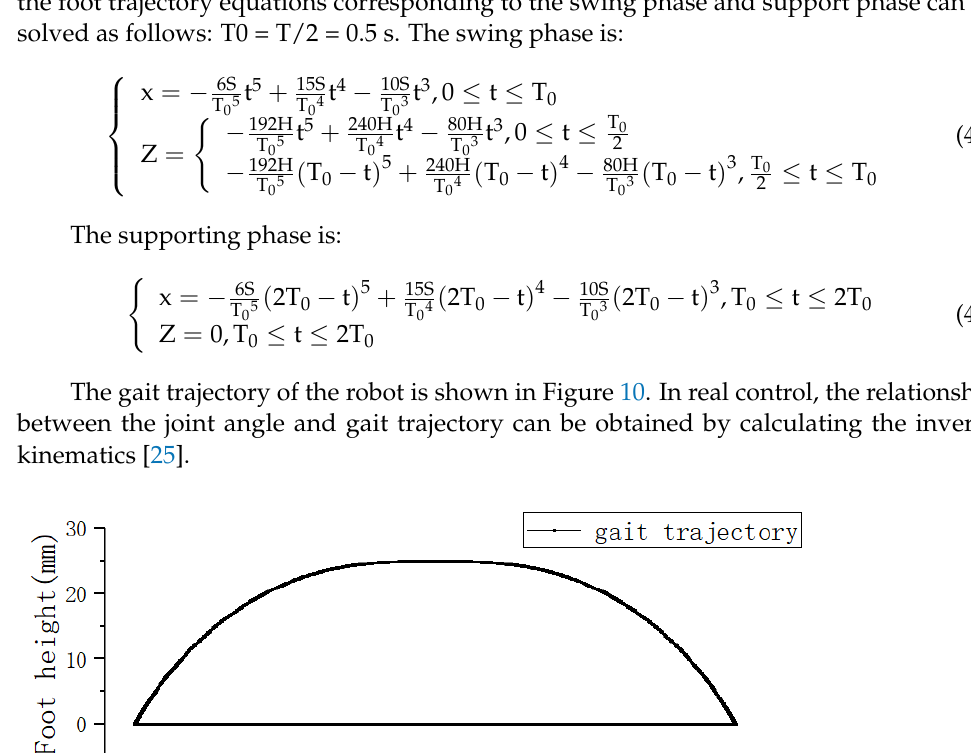
Figure 10. Gait trajectory of robot.